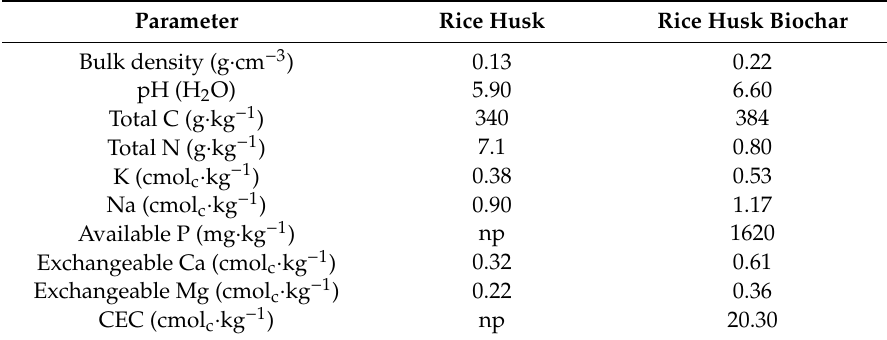
Table 2. Physico–Chemical Properties of the rice husk